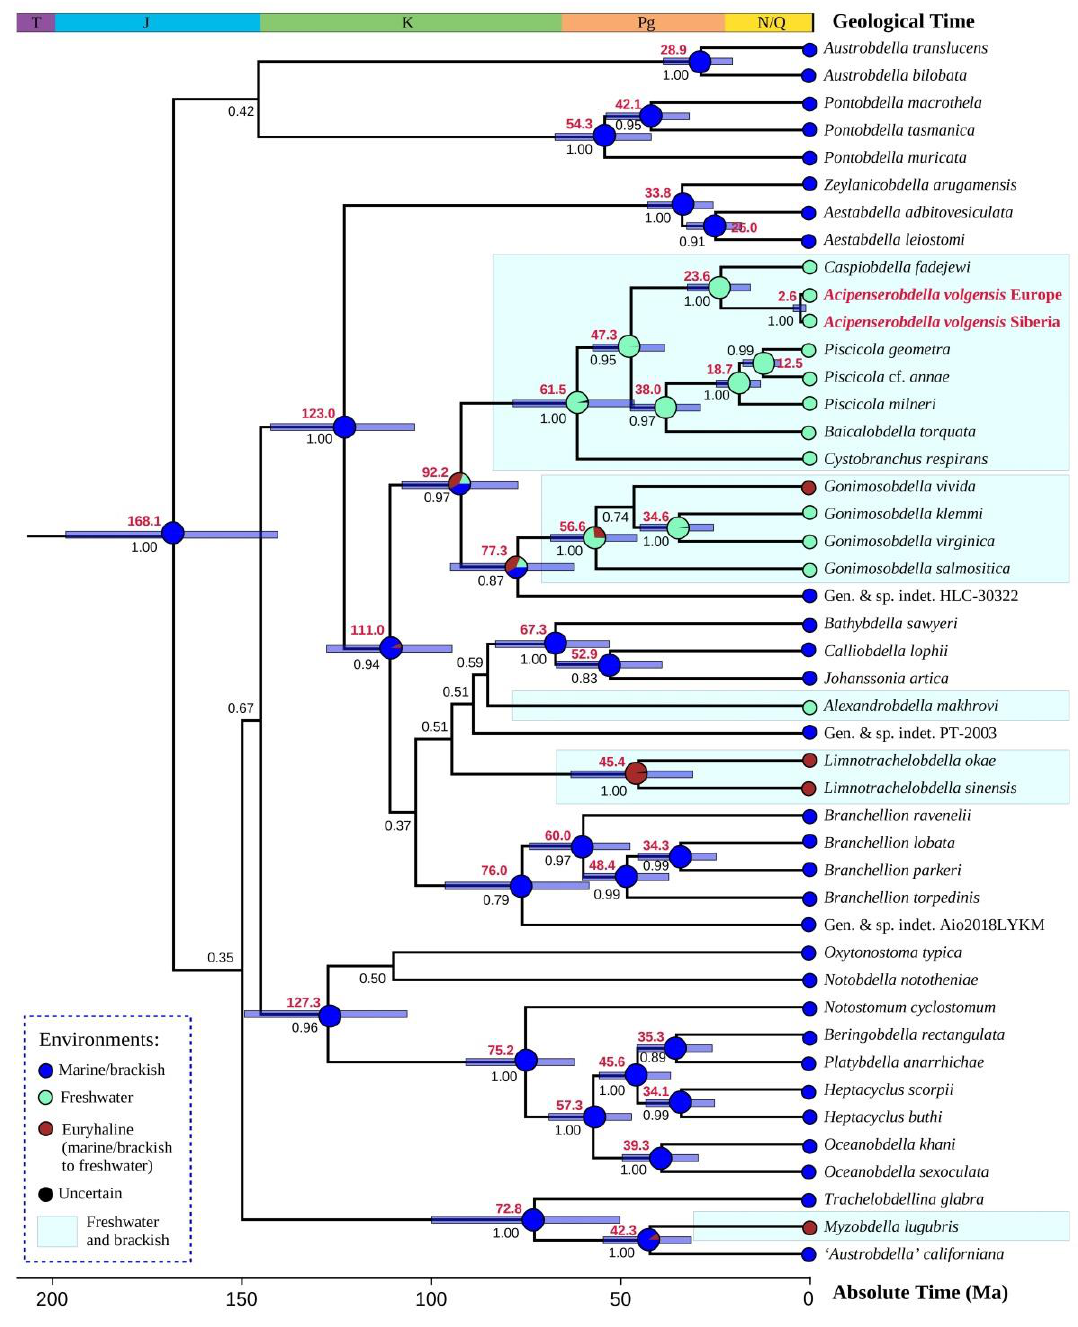
Figure 4. Time-calibrated Bayesian phylogeny (three codons of COI + 18S rRNA ) of the Piscicolidae. The black numbers near nodes are Bayesian posterior probabilities (BPP) of BEAST v. 1.10.4. The red bold numbers near nodes are mean node ages (Ma). The nodal circle charts indicate the probabilities of certain ancestral environments based on the Bayesian Binary MCMC reconstruction. Time and ancestral trait reconstructions for weakly supported nodes (BPP < 0.75) are omitted. Two Ozobranchidae taxa were used as an outgroup (not shown). Stratigraphic chart according to the International Commission on Stratigraphy, 2021 (https://stratigraphy.org/chartaccessed on 19 August